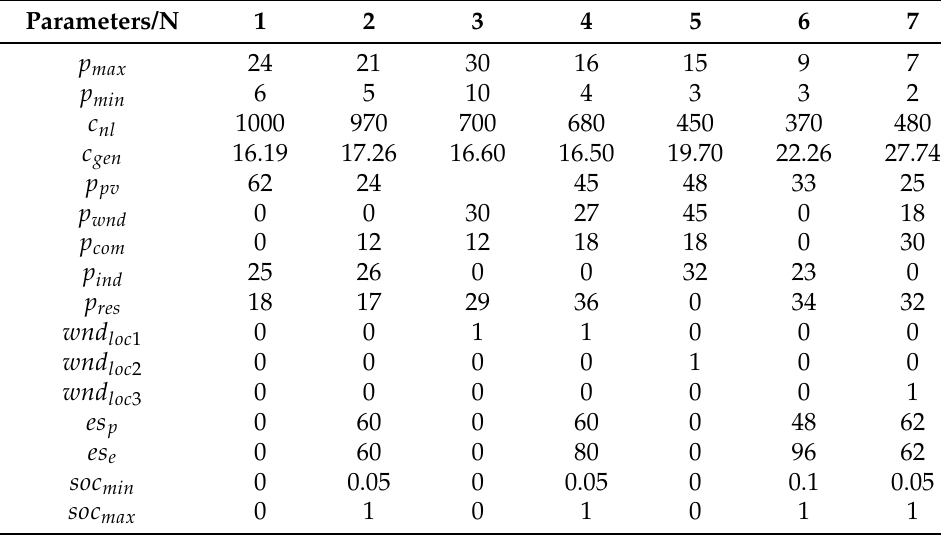
Table A8. Table representing the parameters in DS